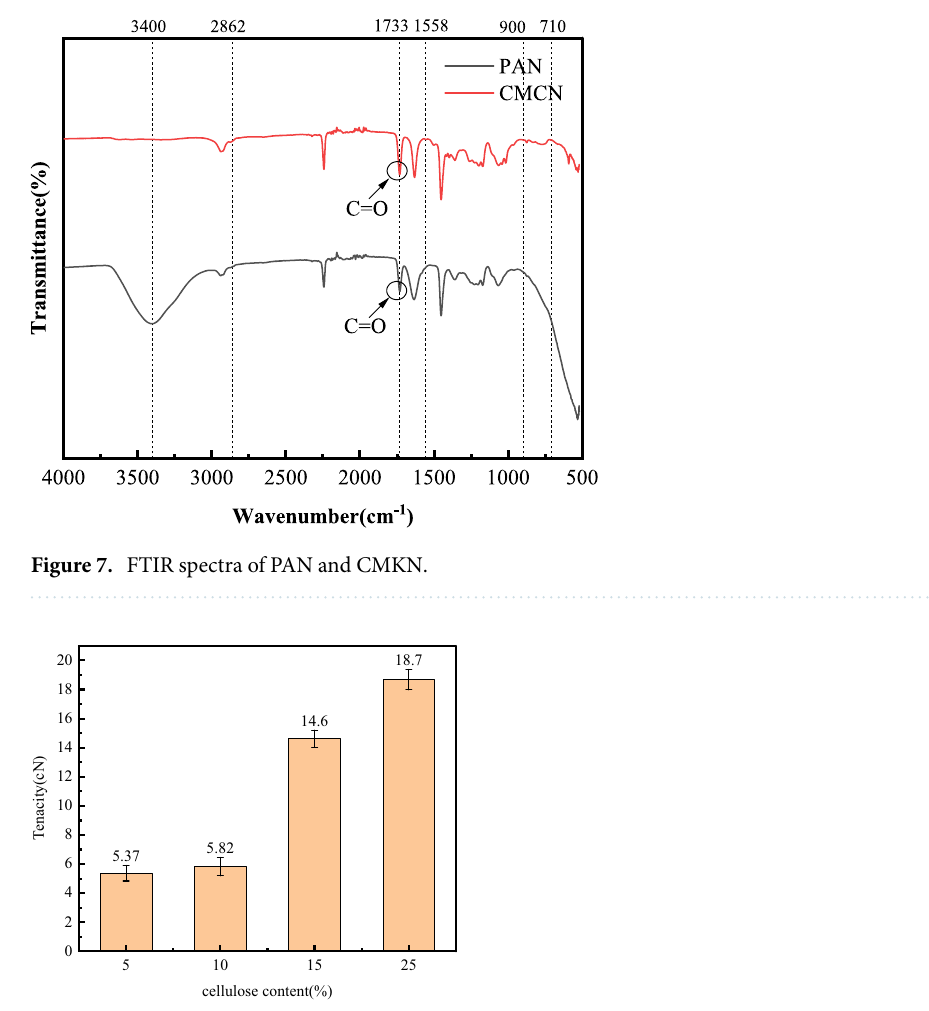
Figure 8. Tensile strength of a spinning fluid with different cellulose